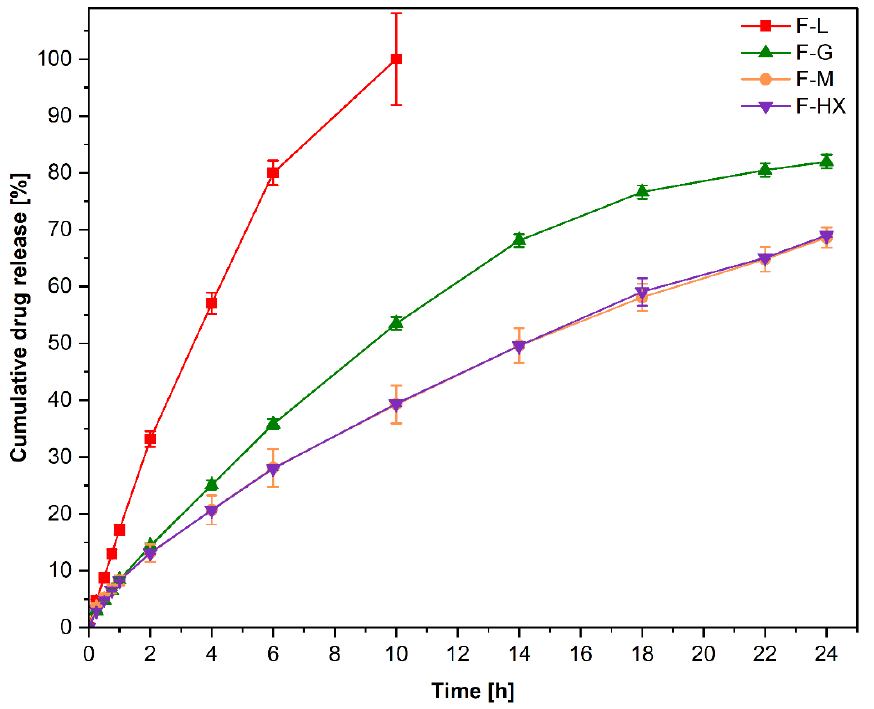
Figure 5. Cumulative diclofenac sodium release from 3D-printed tablets composed of different HEC/HPC combinations in phosphate buffer (pH 6.8) for 24 h. Data are presented as mean ± standard deviation ( n =